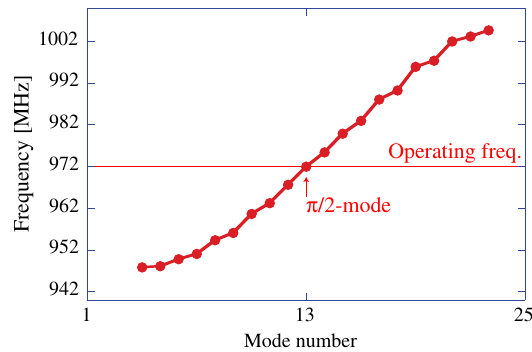
FIG. 9. Dispersion curve obtained from S ing the two antennas attached at both end cells (at the side of the vacuum